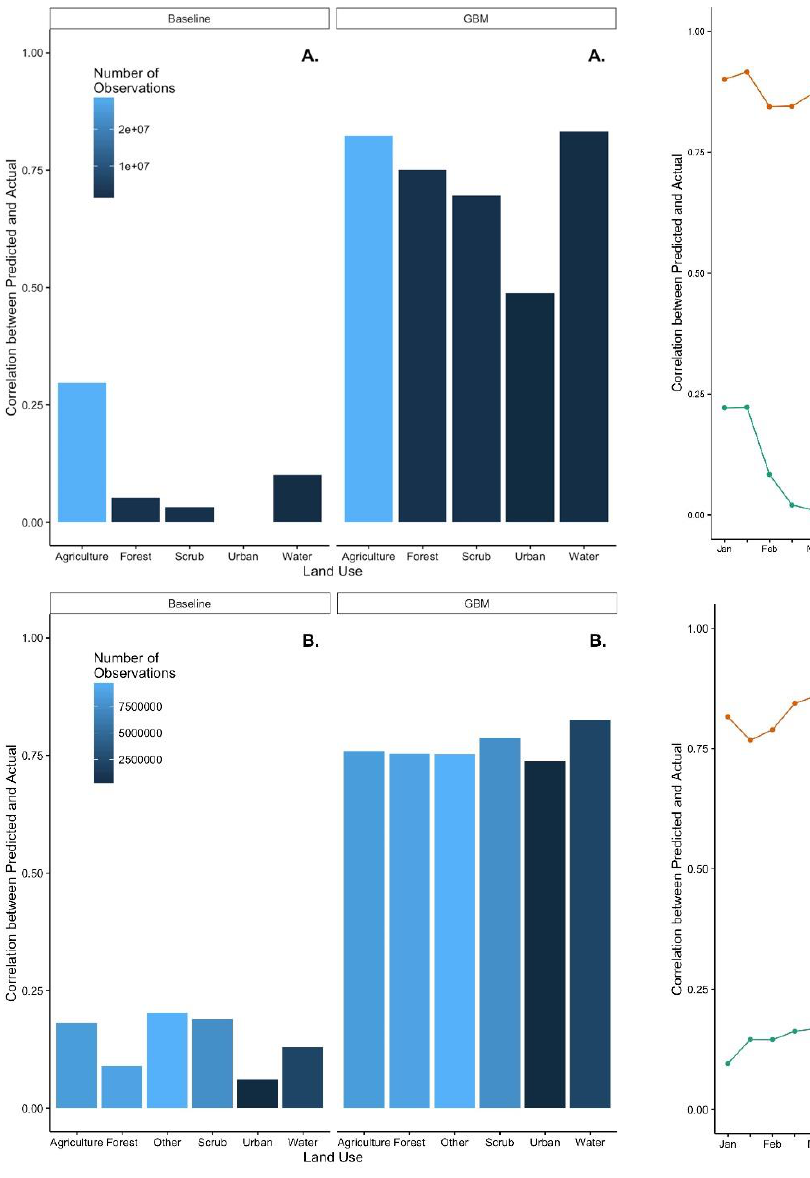
Figure 2: Correlation between predicted and actual EVI in (A) Bangladesh and (B) Sri Lanka across time